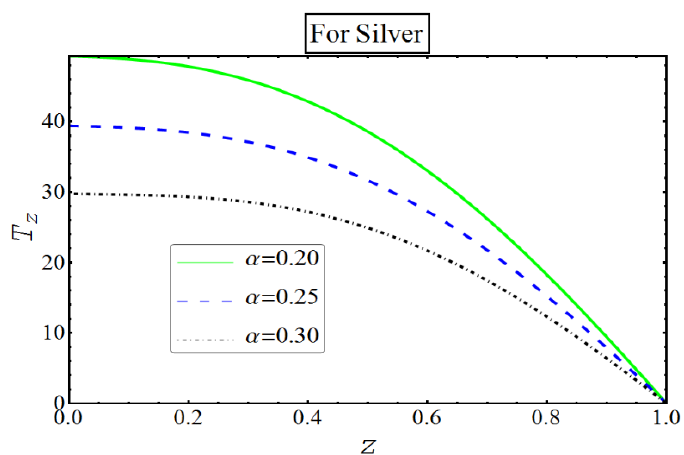
Figure 24. Variation of 𝑇 𝑧 for the thermocapillary parameter.